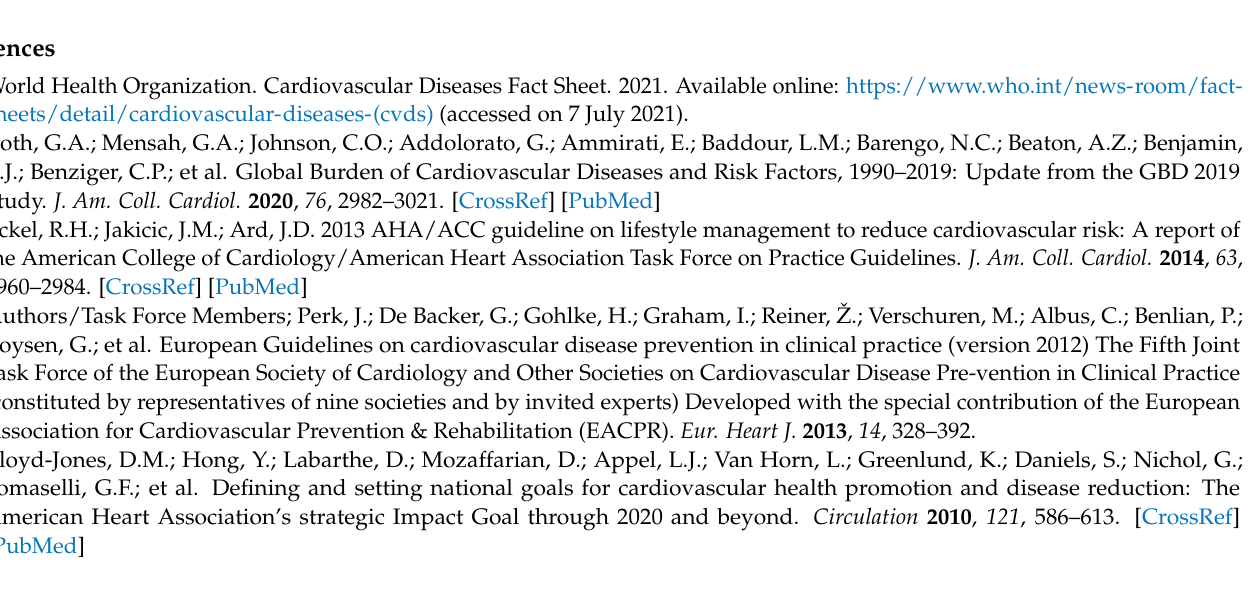
Table S2: Cross tabulation between the place of residence and division of residence ( N =